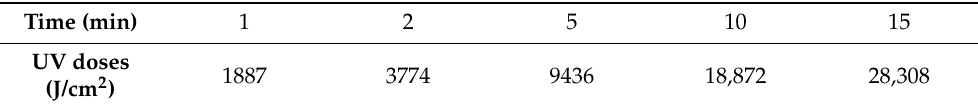
Table 1. Amount of UV doses on the tubes w.r.t. UV irradiance